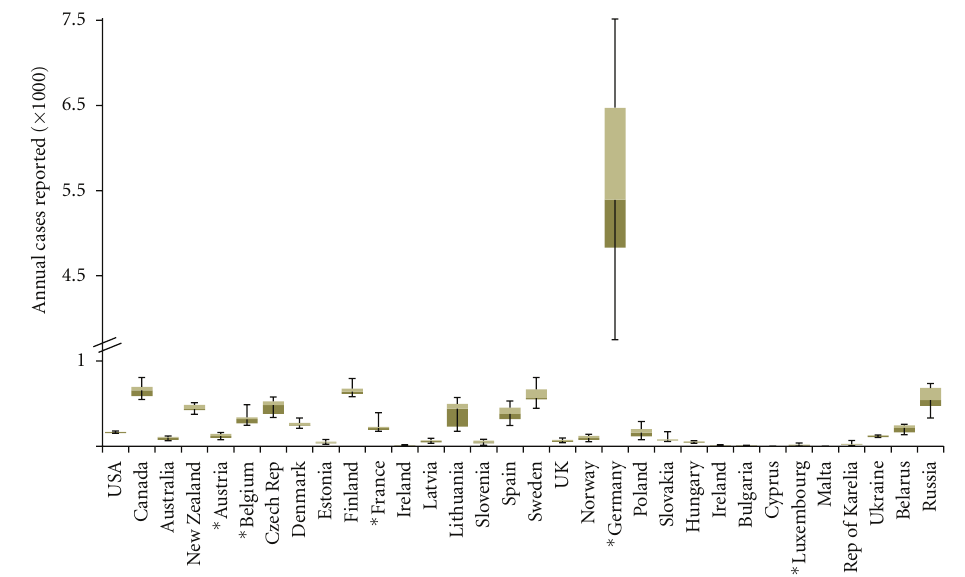
Figure 1: Human yersiniosis cases reported for selected countries that conduct active annual surveillance for the yersiniae. Surveillance data for years 2000 to 2009 were collected from national repositories for Canada (National Microbiology Laboratory, http://www .publichealth.gc.ca), the United States (FoodNet, http://www.cdc.gov/foodnet), 24 European Union members (European Food Safety Authority, http://www.efsa.europa.eu), New Zealand (The Institute of Environmental Science and Research, http://www.surv.esr.cri.nz), Australia (OZFoodNet, http://www.ozfoodnet.gov.au), Northwestern Russia, the Republic of Karelia, Ukraine, and Belarus (EpiNorth Project, http://www.ozfoodnet.gov.au). Russian data was obtained only from the following participating regions: Arkhangelsk oblast, Kaliningrad oblast, Leningrad oblast, Murmansk oblast, Nenets Autonomous okrug, Novgorod oblast, Pskov oblast, St. Petersburg City, Vologda oblast, and the Republic of Komi. For comparison, countries defined as Western European nations based on the classification scheme used by the United Nations include Austria, Belgium, France, Germany, and Luxembourg (which are marked with an asterisk). As shown, Germany reported the greatest number of human cases per annum for the ten-year period included (years 2000–2009), compared to all other countries examined, including the bordering countries of Denmark, Poland, Czech Republic, Austria, and France. The annual cases reported are shown on the ordinate , with the axis broken between 1,000 and 4,500 cases to allow the inclusion of Germany and other countries in one graphical display. Yearly cases were not adjusted for population di ff erences. Individual countries are listed on the abscissa . USA: United States; UK: United